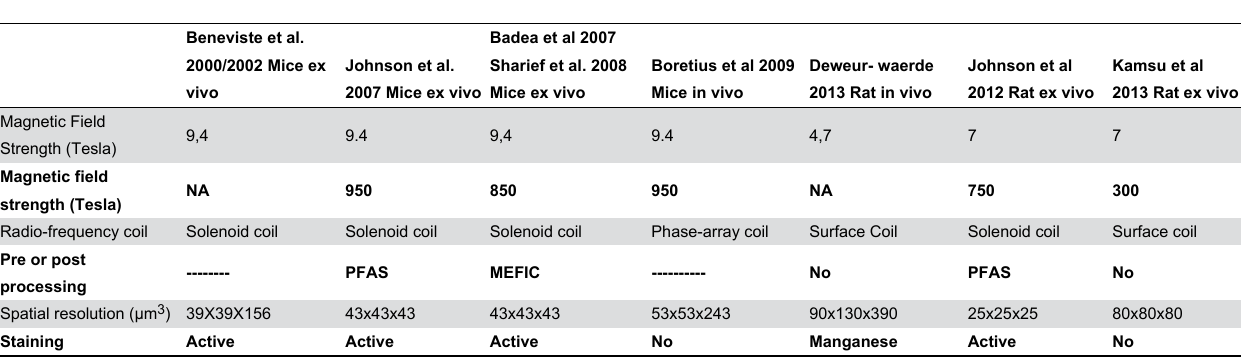
Table 6. MRI tools